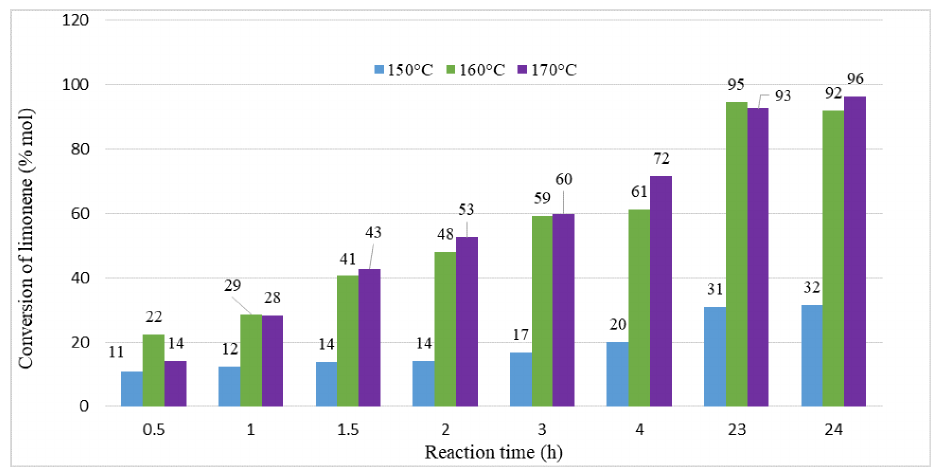
Figure 2. The influence of the isomerization temperature on the conversion of R( + )-limonene. The amount of the catalyst was 15 wt %.